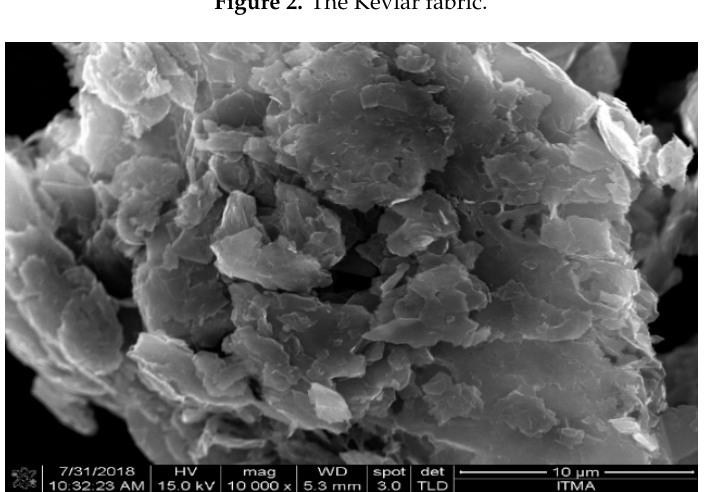
Figure 3. An Field Emission Scanning Electron Microscope (FE-SEM) image of the Graphene nanoplatelets (GNPs). Table 2. The specifications of GNPs.